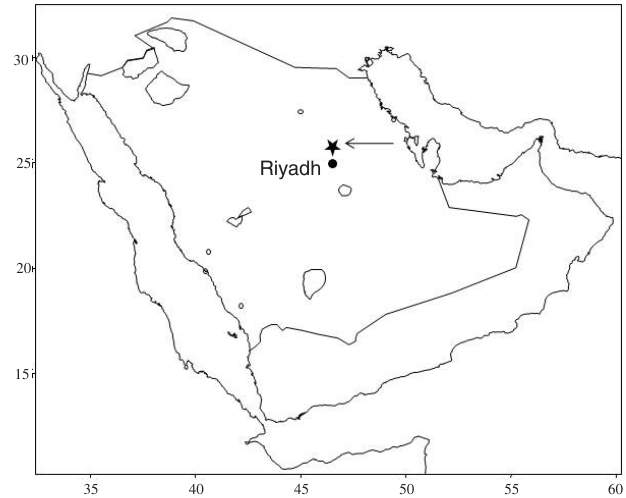
Figure 1. The study site at Thumamah indicated north of Riyadh in central Saudi